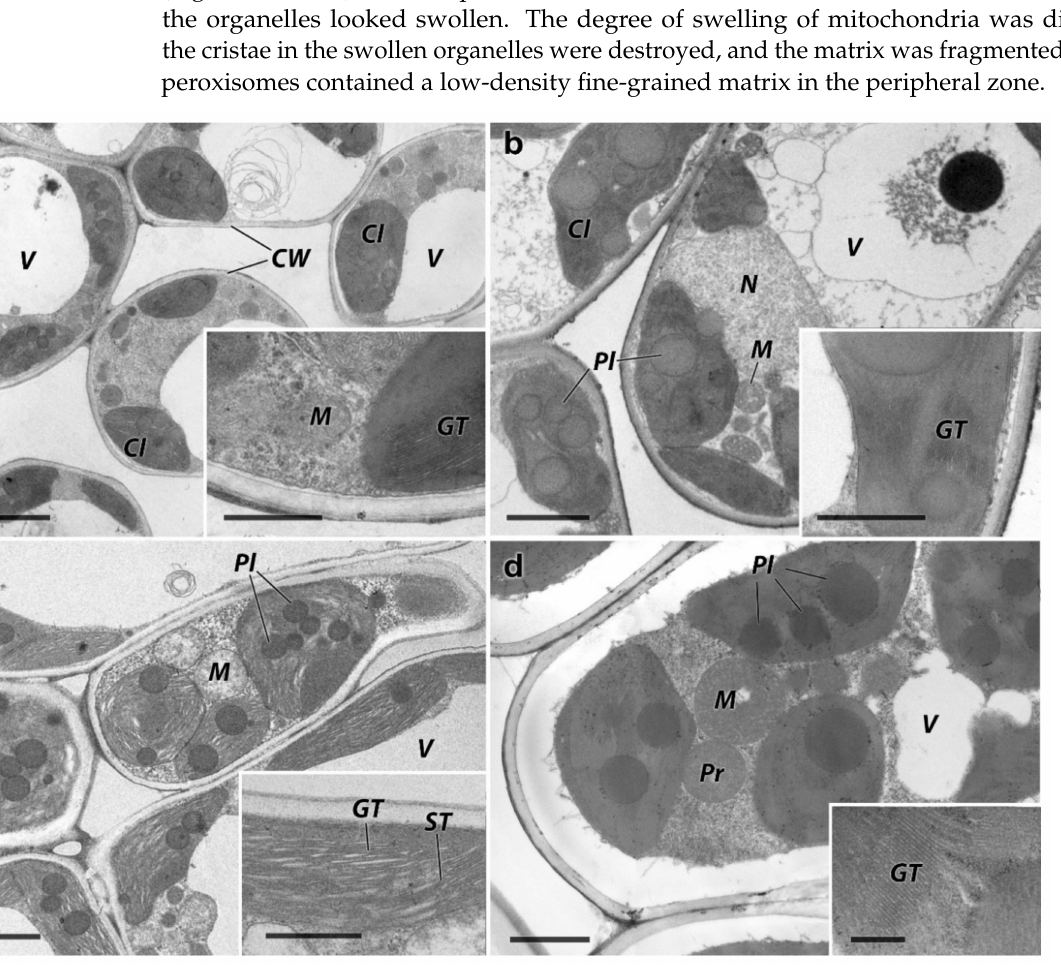
Figure 9. TEM micrographs of ultrathin cross-sections of the leaves; T. australis : ( a ) background plot (5K), ( b ) polluted plot (8K); T. laxmannii : ( c ) background plot (T1), ( d ) polluted plot (T4); CW—cell wall. Cl—chloroplast; P—plastoglobule; GT—thylakoids gran; ST—thylakoids strom; N—nucleus; M—mitochondria; Pr—peroxisome, V—vacuole. The scale bar is ( µ m): ( a )—3, inset—0.4, ( b )—2, inset—1, ( c )—2, inset—1, ( d )—4,